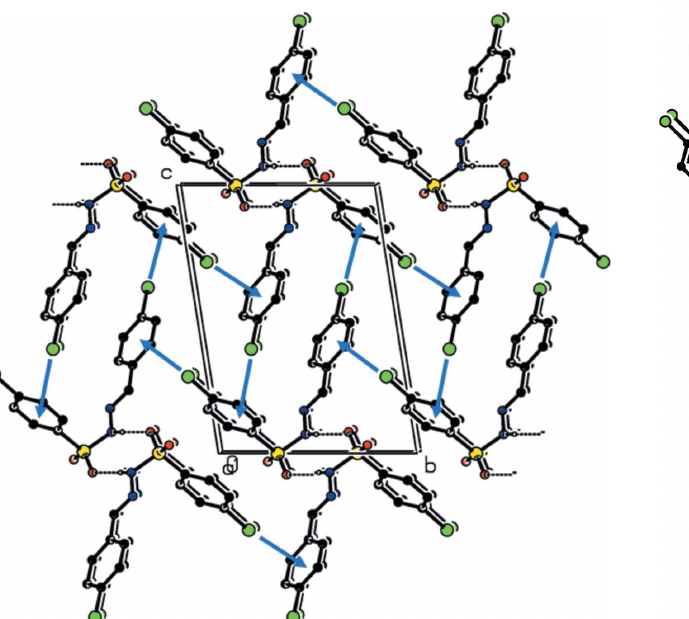
Figure 5 Crystal packing of (II), viewed along the b axis, with hydrogen bonds shown as dashed lines. H atoms not involved in these interactions have been